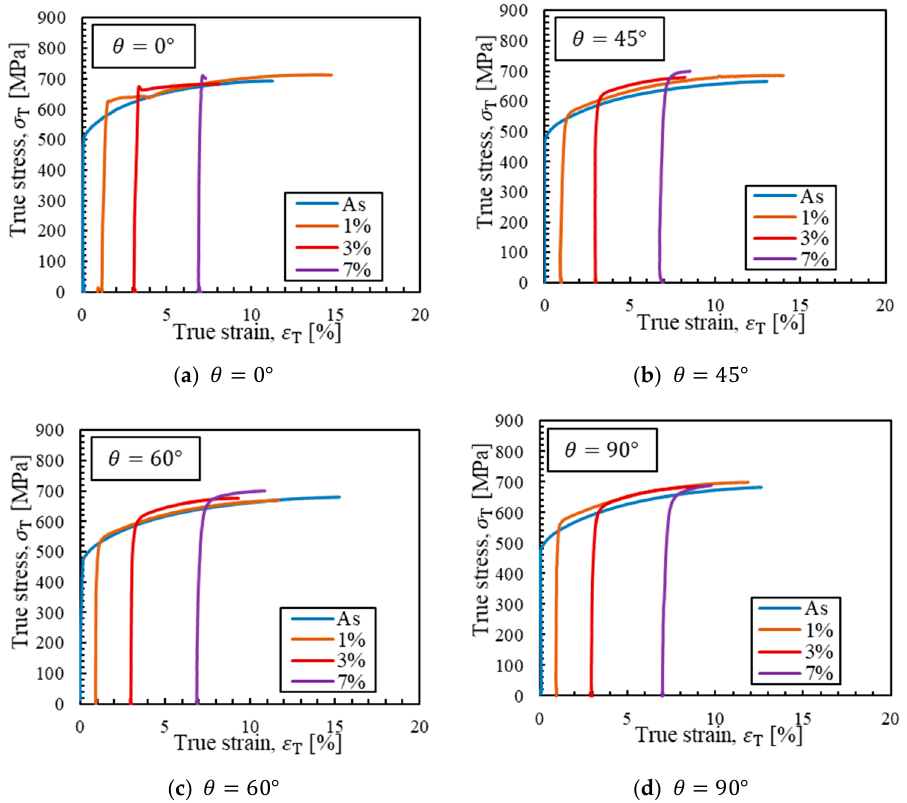
Figure 3. True stress-true strain curves before/after prestraining. ( a ) 𝜃 = 0° , ( b ) 𝜃 = 45° , ( c ) 𝜃 = 60° , ( d ) 𝜃 = 90°